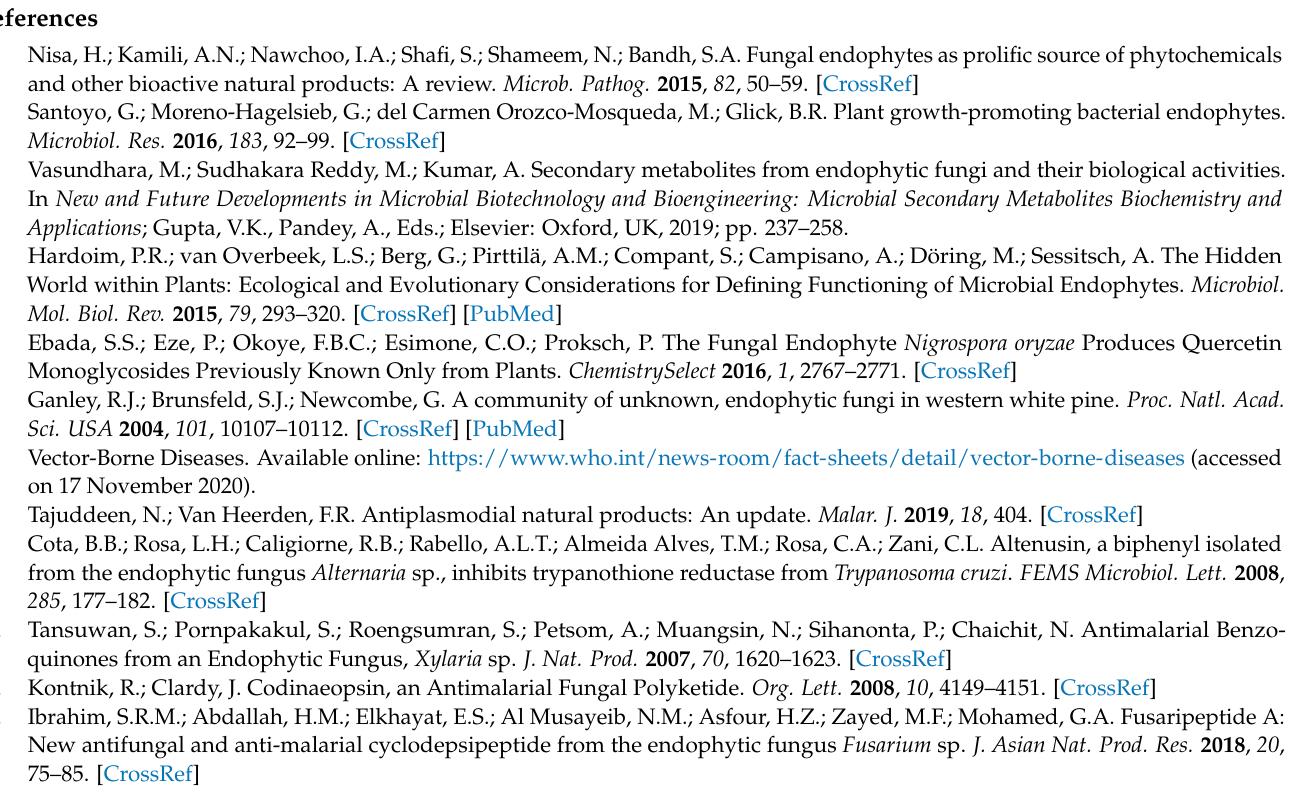
and blue NMR signals) and L-Ile standard amino acid (green and yellow NMR signals); Figure S15. Overlay of HSQC NMR spectra of a hydrolysate of pipecolisporin ( 1 ) (red and blue NMR signals) and L- allo -Ile standard amino acid (green and yellow NMR signals); Figure S16. Growth inhibition curve of pipecolisporin ( 1 ) against T. cruzi ; Figure S17. Growth inhibition curve of benznidazole against T. cruzi ; Figure S18. Growth inhibition curve of pipecolisporin ( 1 ) against P. falciparum 3D7; Figure S19. Growth inhibition curve of chloroquine against P. falciparum 3D7; Figure S20. Growth inhibition curves of pipecolisporin ( 1 ) against human cell lines; Figure S21. Nigrospora oryzae CF-298113. Upper surface overview of a 21 days culture after inoculation on (a) Yeast-Malt medium; (b) cornmeal medium; Figure S22. Conidiogenous cells giving rise to conidia. Scale bars: a–c = 10 µ